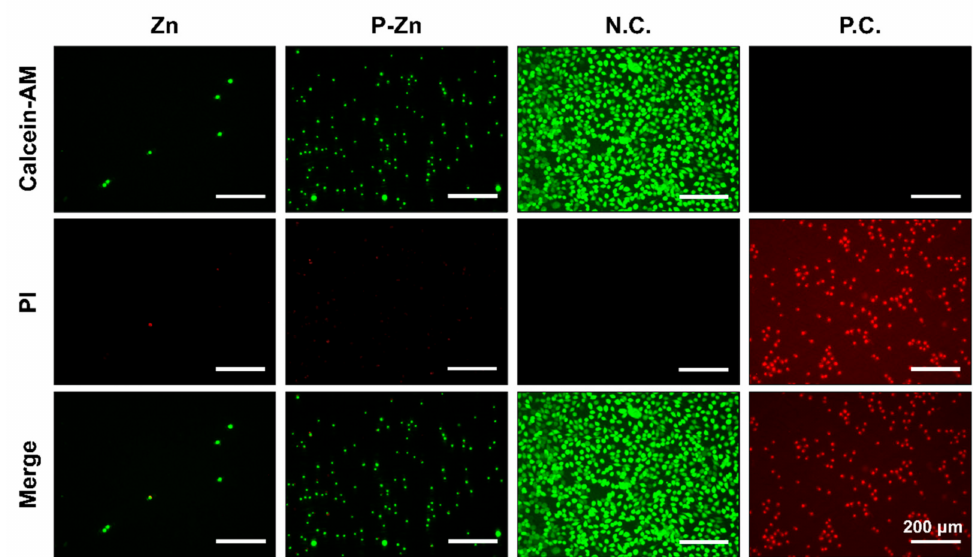
Figure 3. Representative fluorescent live/dead staining of L929 fibroblasts cultured on sample surfaces for 24 h. A titanium-based alloy was used as negative control (N. C.) and pure copper was used as a positive control (P. C.). Green fluorescence represents living fibroblasts stained with calcein-AM, and red fluorescence represents apoptotic cells with compromised membrane integrity, stained with PI. (magnification 100 × ; scale bar = 200 µ m).